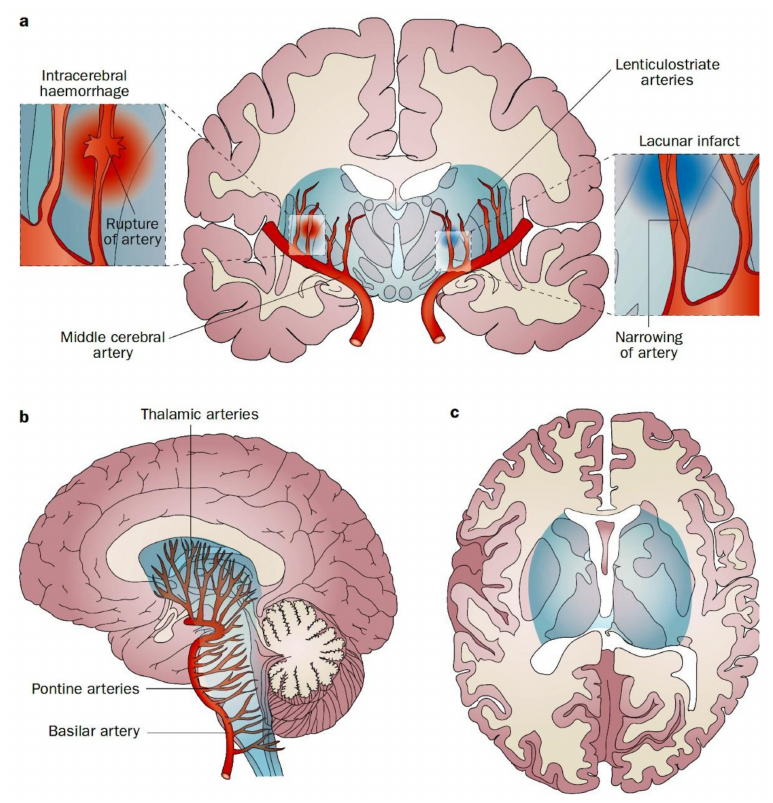
Figure 1. The Vascular Centrencephalon. Pathophysiology of lacunar infarction and haemorrhagic stroke. End arteries originate perpendicularly from the major vessels of the anterior and posterior circulation, without substantial collaterals from adjacent arteries. These arteries are particularly vulnerable to arterial hypertension, which causes fibrinoid degeneration and microaneurysms of the vessel wall, and results in narrowing (lacunar ischaemic infarct) or rupture (intracerebral haemorrhage) of arteries. End arteries supply the vascular centrencephalon (blue region), which represents phylogenetically older parts of the brain (including the brainstem, basal ganglia and thalamus), and adjacent white matter. ( a ) Coronal view. ( b ) Sagittal view. ( c ) Axial view. (Reproduced